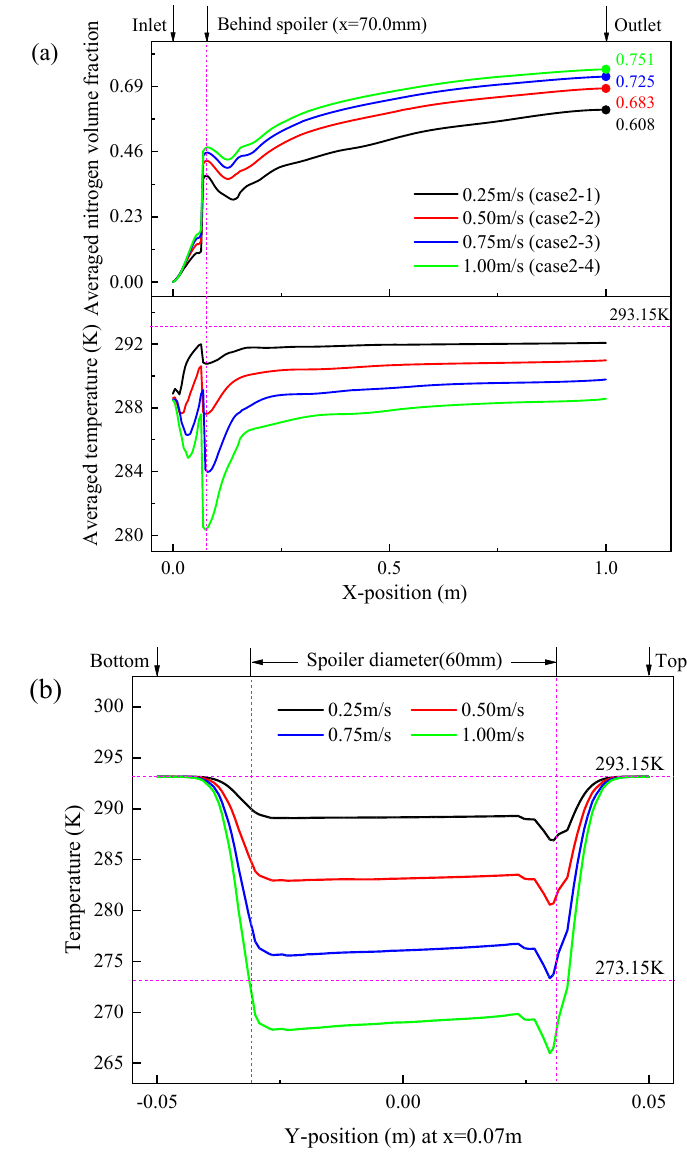
Figure 6. The N 2 volume fraction and the temperature of cross sections at X ‐ positions ( a ), and the temperature of Y ‐ positions at x = 0.07 m ( b ), with different LN 2 flow rates. Excessive LN 2 will cause a possible phenomenon that the foam solution may freeze, corresponding to the literature [21]. Even if a large amount of LN 2 is near the inlets, it will not lead to ice formation, because the LN 2 is broken into small droplets by the cone spoiler. The minimum average temperature of the cross section is at the spoiler tail (x = 0.07 m), where the lowest temperature exists. The temperature in the central axis (Y ‐ axis) of the cross section at x = 0.07 m is extracted as shown in Figure 6b. In accordance with the boundary conditions, the temperature of the position near the pipe wall descends from 293.15 K. The asymmetry of the curves is caused by the density and temperature differ ‐ ences of fluids between the upper and lower sides of the spoiler. After impacting the